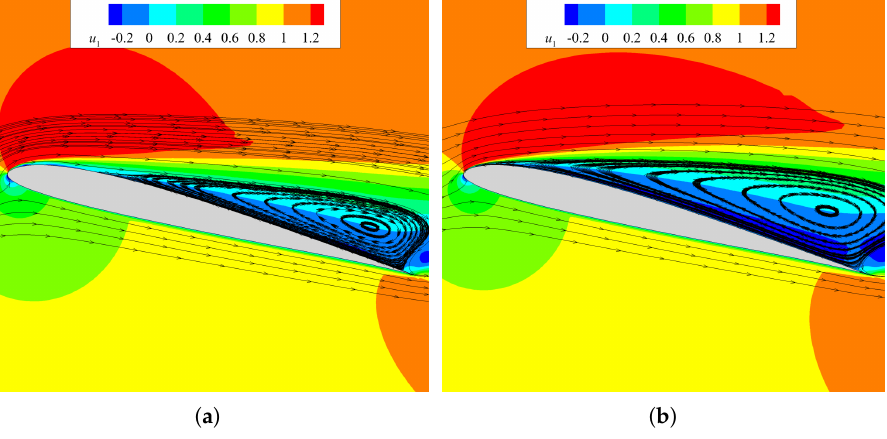
Figure 13. Time − dependent case. Contour of the mean streamwise velocity u 1 . SA − BCM model ( a ) and SA model ( b